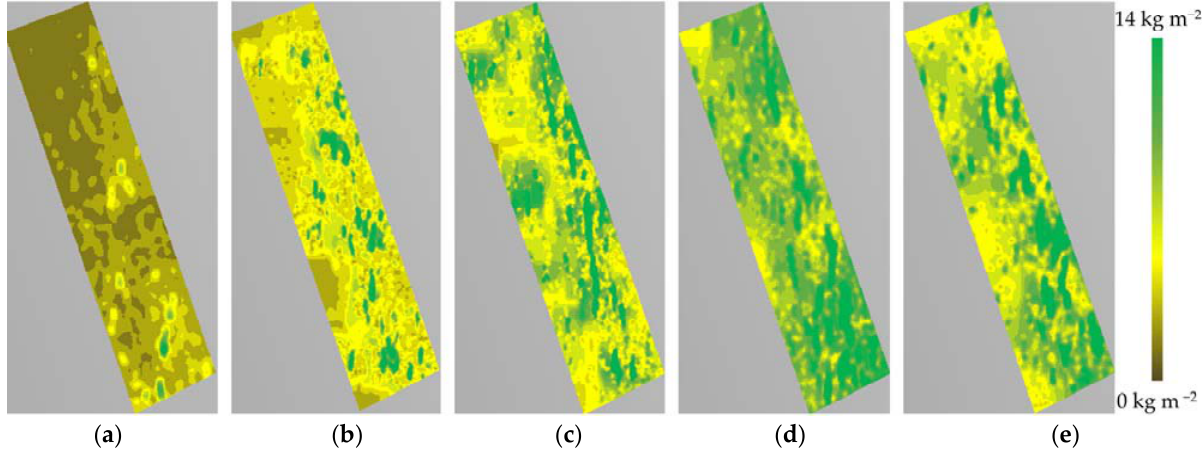
Figure 12. Estimated AGB maps by the band-weighted AGB model from ( a ) 19 December 2019, ( b )